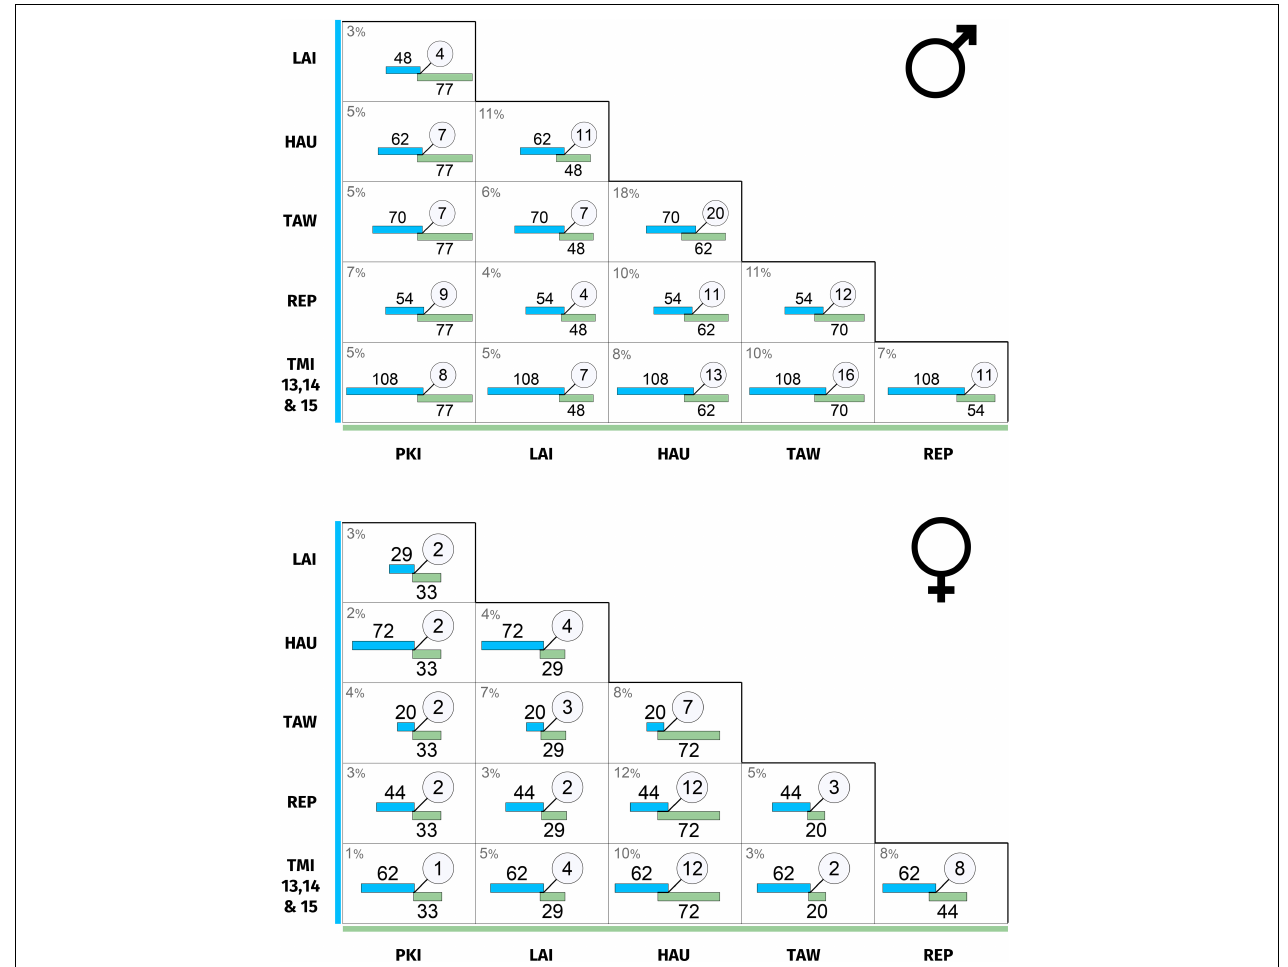
FIGURE 4 | (Top) Male population repertoire overlap between sites. (Bottom) Female population repertoire overlap between sites. Each cell indicates the recorded number of syllable types for the two sites (blue and green bars), and the number of types common to both (circle). The percentage overlap is given at the top left of each cell and is calculated as Jaccard similarity index: number of shared types divided by total number of types. For robustness, repertoires exclude types with fewer than three occurrences within that site and sex. Bar length is proportional to the number of syllable types, and overlap length is proportional to the shared number of syllable types. Site abbreviations are as follows: PKI, Tawhiti Rahi (representing Poor Knights Islands); LAI, Lady Alice Island (representing Hen and Chickens); HAU, Hauturu; TAW, Tawharanui; REP, Repanga; TMI,